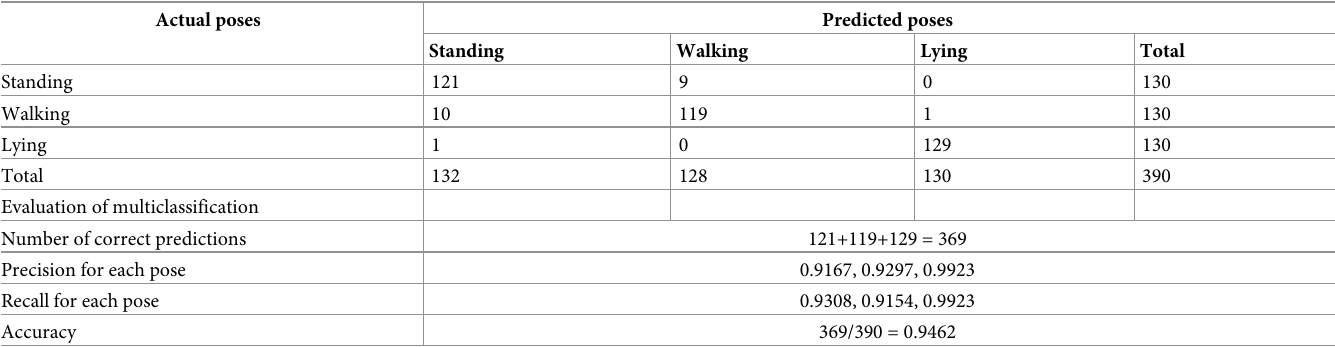
Table 2. Confusion matrix of pose classification.